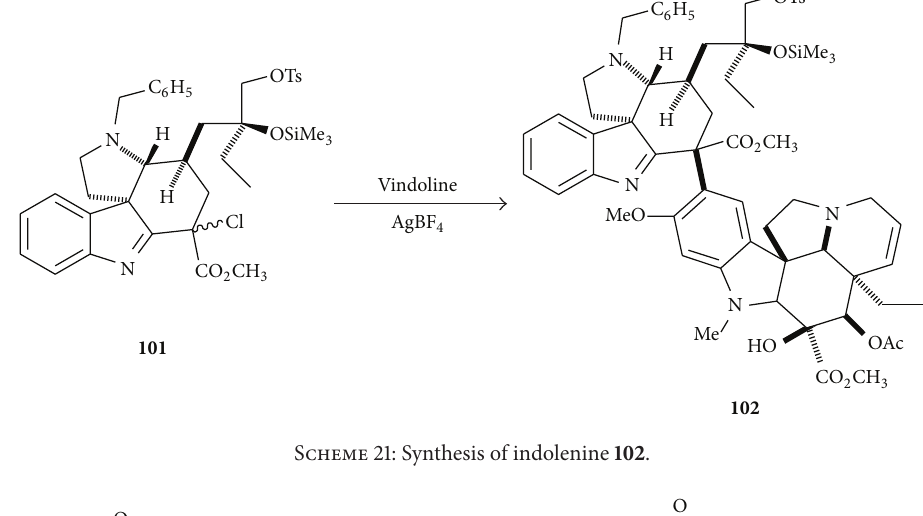
Scheme 21: Synthesis of indolenine 102 .